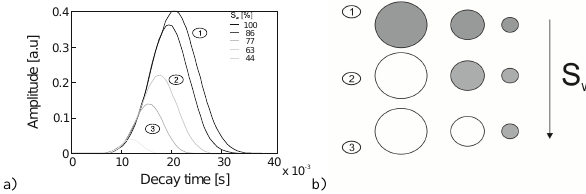
Figure 1. (a) NMR decay time distributions at different water sat- uration levels for a classical cylindrical capillary pore distribution. (b) Concept sketch of saturated (gray) and desaturated capillaries, e.g., during drainage.